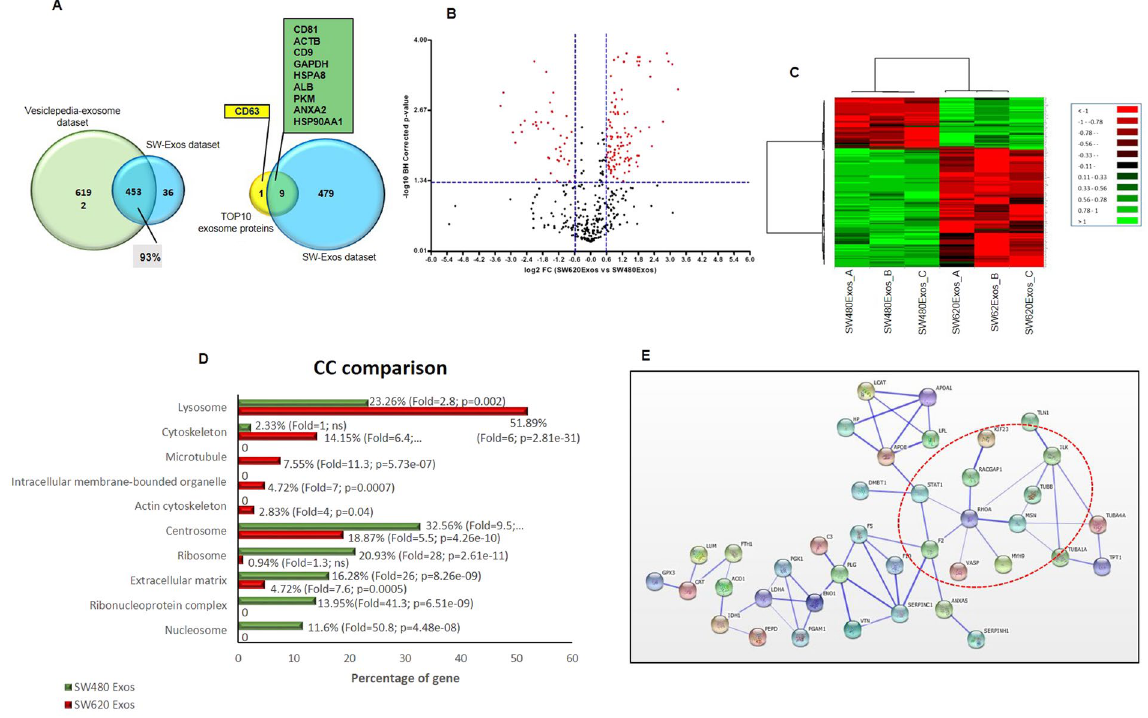
Figure 6. Analysis of protein content of exosomes derived from SW480 and SW620 cells. ( A ) Venn diagrams illustrating comparison of proteins detected in SW-Exos and Vesiclepedia-exosome dataset (on the left) and the Vesiclepedia-Top10 exosome proteins (on the right). ( B ) Volcano plot of the log2 Fold Change SW620Exos/ SW480Exos (x-axis) versus the -log10 BH corrected p-value (y-axis) of the 415 quantified proteins. The dashed lines correspond to 1.5-fold up and down (vertical lines), and an FDR value of 0.05 (horizontal line). The red points in the plot represent the 150 proteins that in the two exosome populations are differentially represented with statistical significance. ( C ) Heat map analysis of 150 proteins among three biological replicates between the SW480Exos and SW620Exos. The log10 value of the MS signal intensity is shown. ( D ) Cellular Component (CC) enrichment in SW480Exos and SW620Exos. In correspondence of each bars percentage of gene, fold enrichment and p value are reported; ns: non significant. ( E ) The protein network analysis performed using STRING v10.0 with a confidence level of 0.6 revealed the presence of RhoA partners among the proteins enriched in SW620Exos. The thickness of the connecting line represents the strength of the